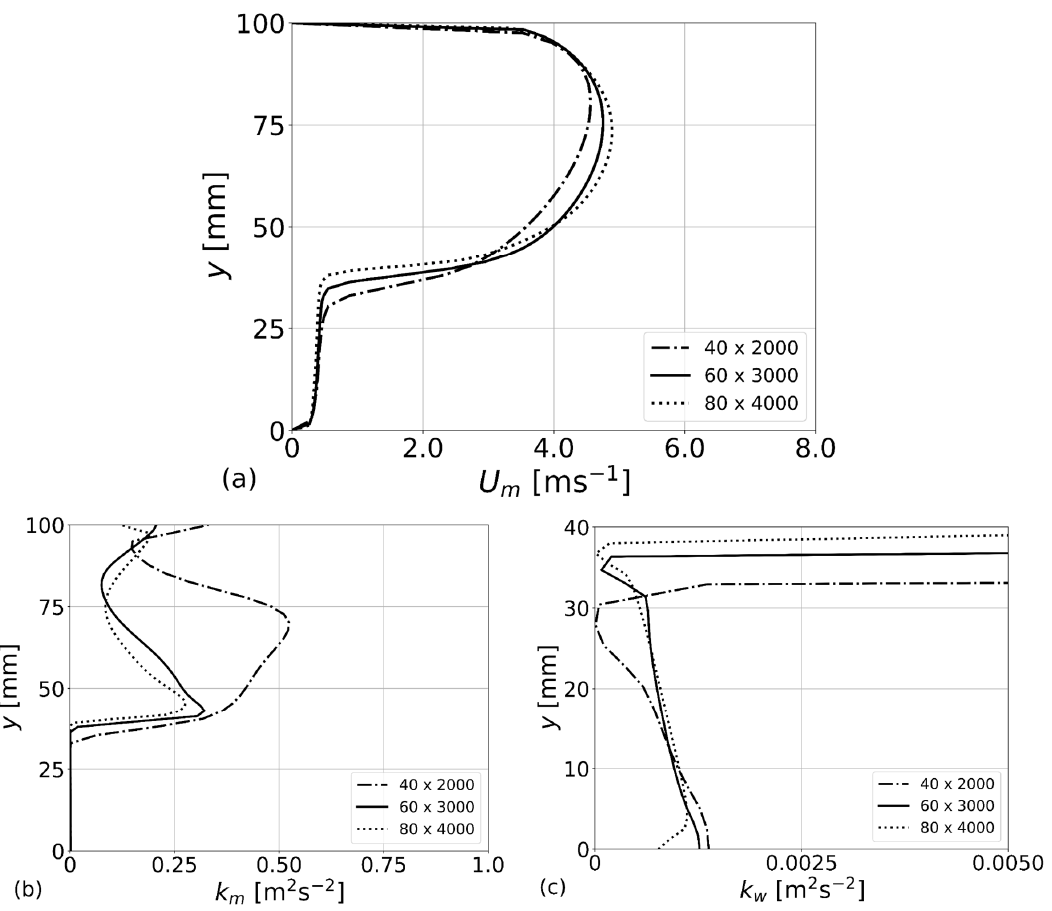
Figure A1. Results of the mesh sensitivity study for the 250 experiment of Fabre et al. [30]: ( a ) velocity; ( b ) turbulent kinetic energy; ( c ) turbulent kinetic energy in the water phase.